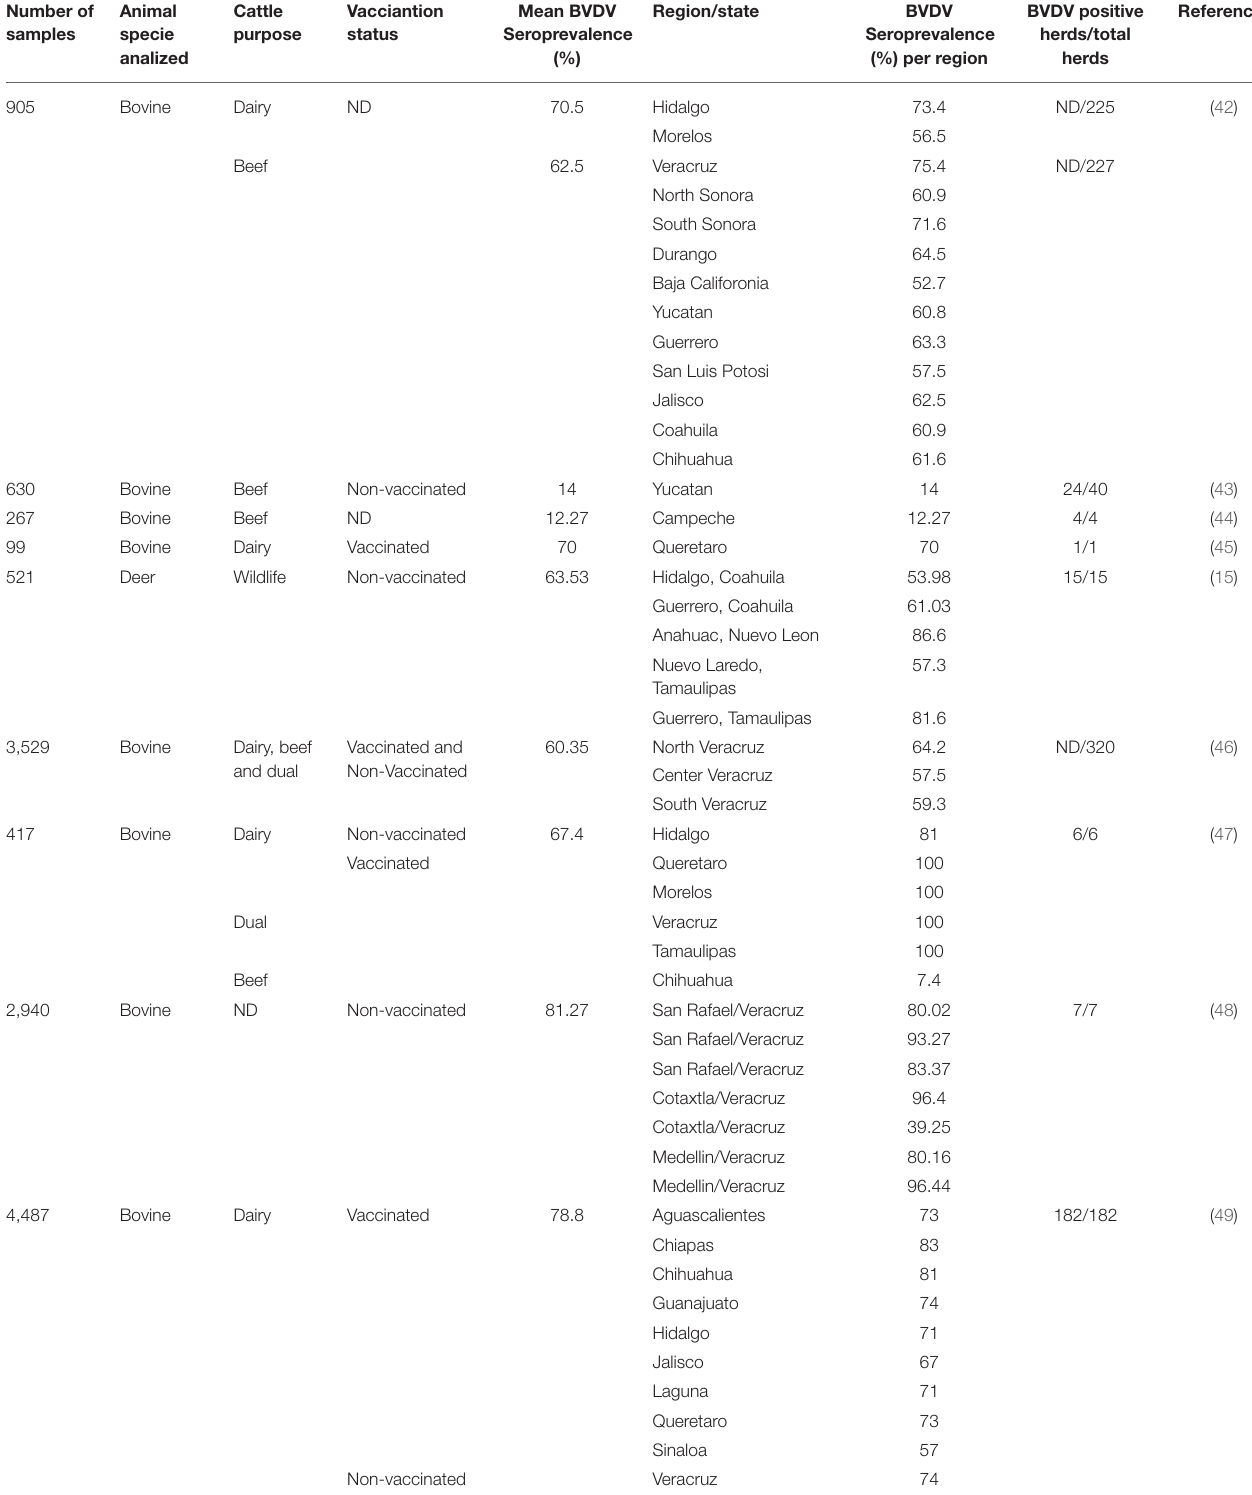
TABLE 1 | Seroprevalence studies performed in cattle from Mexico. Number of Animal samples specie